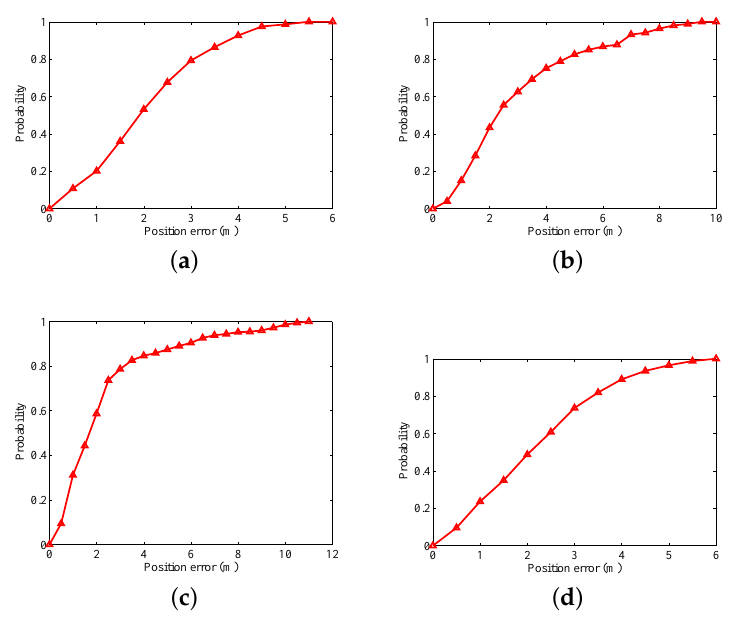
Figure 13. CDF with different gestures: ( a ) calling; ( b ) dangling; ( c ) handheld; and ( d ) Pocket. To further verify the stability of the system, six volunteers participated in the walking experiment.